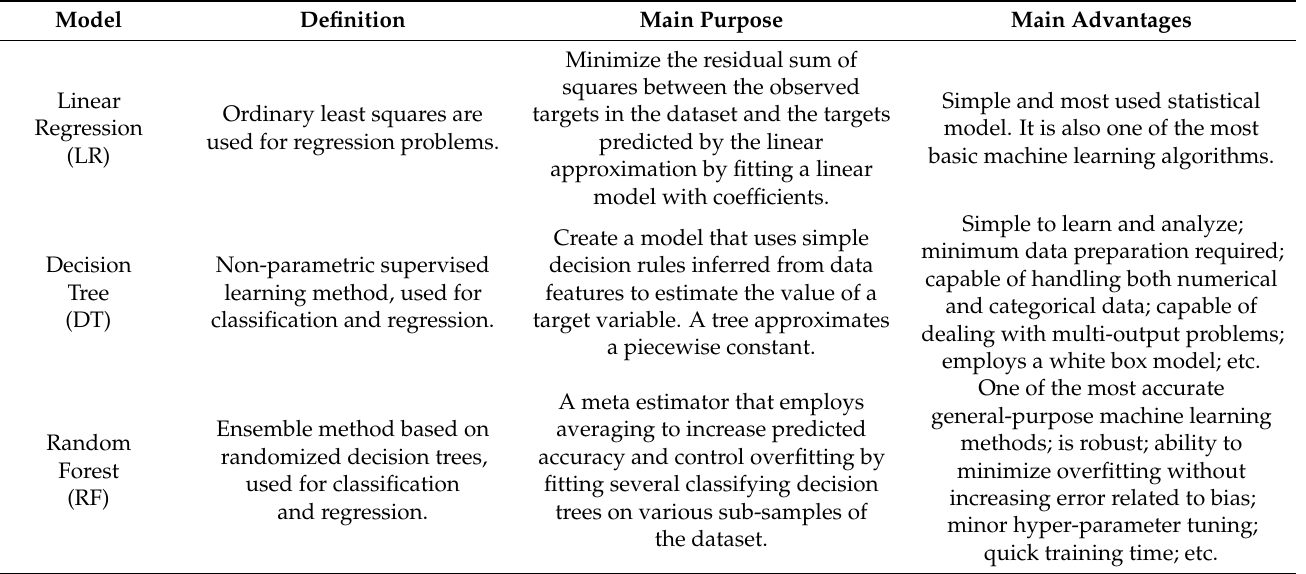
Table 3. Overview of each model